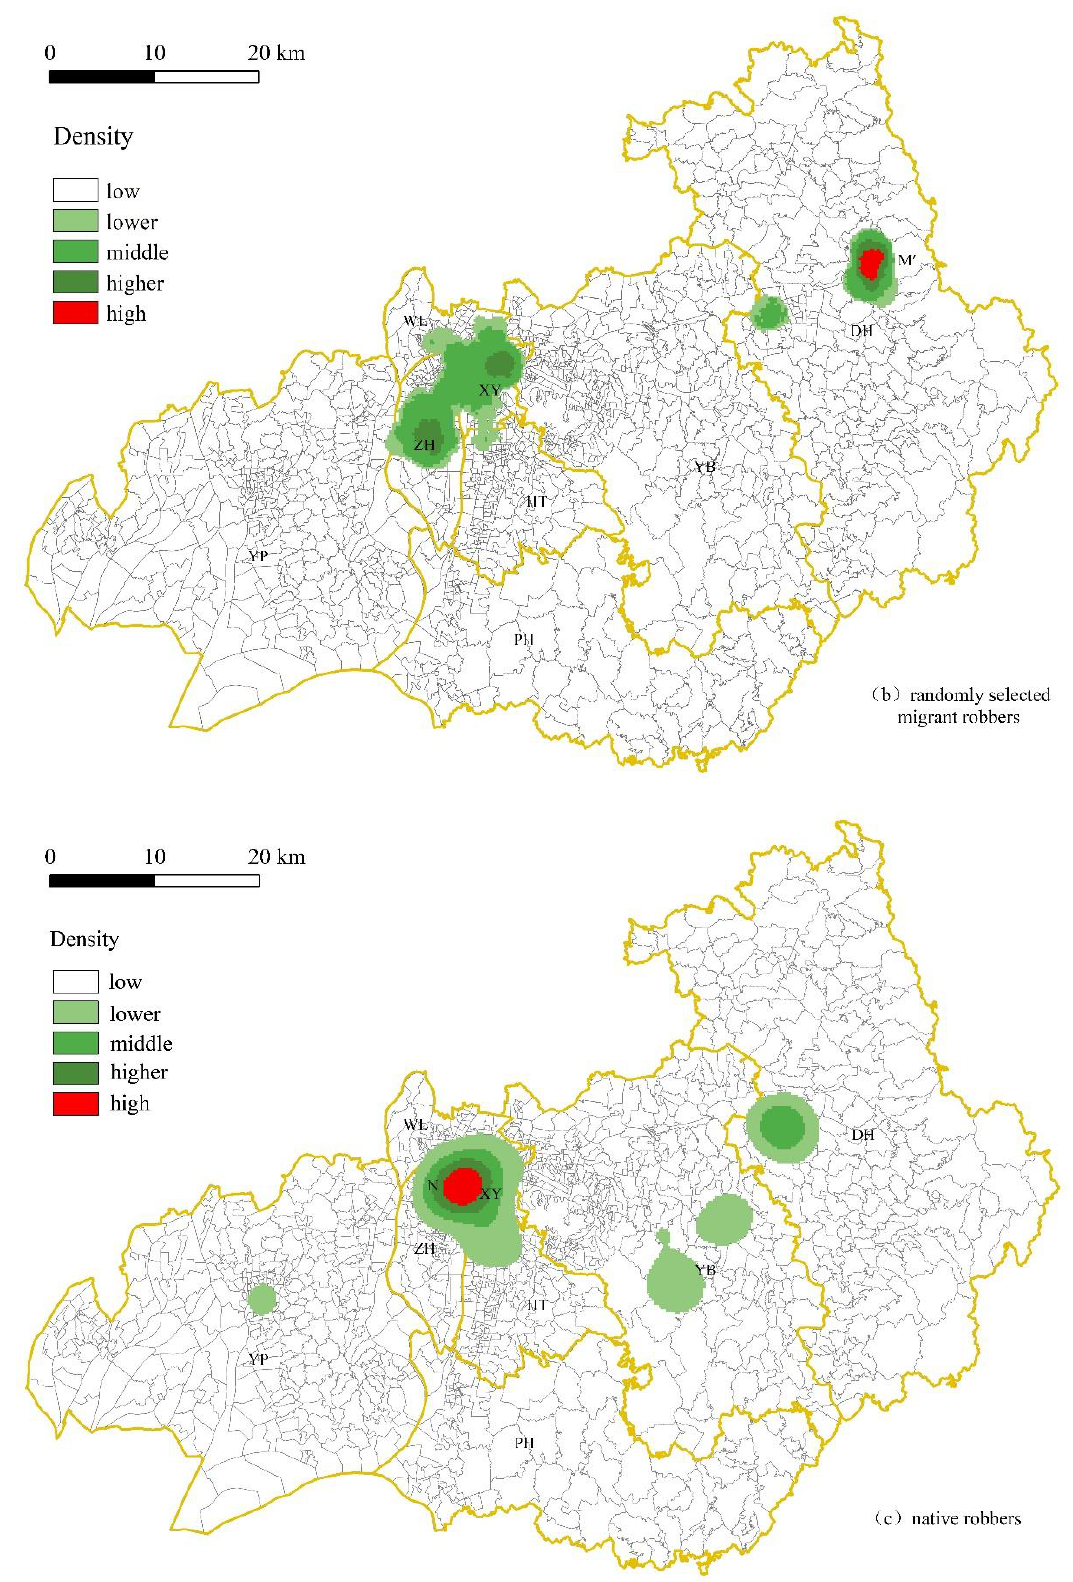
Figure 2. Kernel density estimation of street robbers’ crime location choices. (( a – c ) respectively represent the spatial distribution of crime location choices for all migrant robbers, randomly selected migrant robbers, and native robbers. The data provider requested for confidentiality of the place names, so “ pinyin ” codes are used as substitutes). Meanwhile, a comparison between Figure 2a,b suggests that the crime location choice of the 3560 migrant robbers is similar to those of the 708 randomly selected migrant rob- bers. For example, both Figures show the same hot spot in location M, and both show the